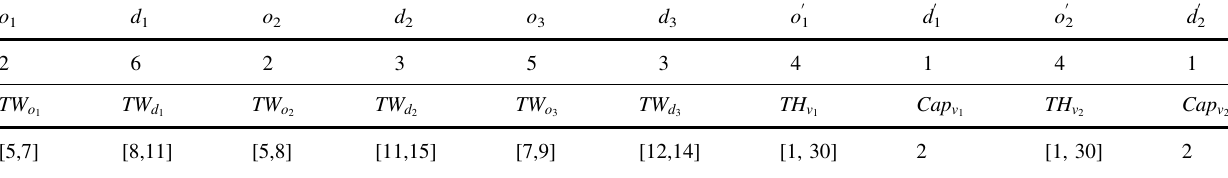
Fig. 14 Space–time trajectory of the vehicle for the example with extra passenger waiting time Table 10 Passengers’ origin–destination pairs and corresponding departure and arrival time